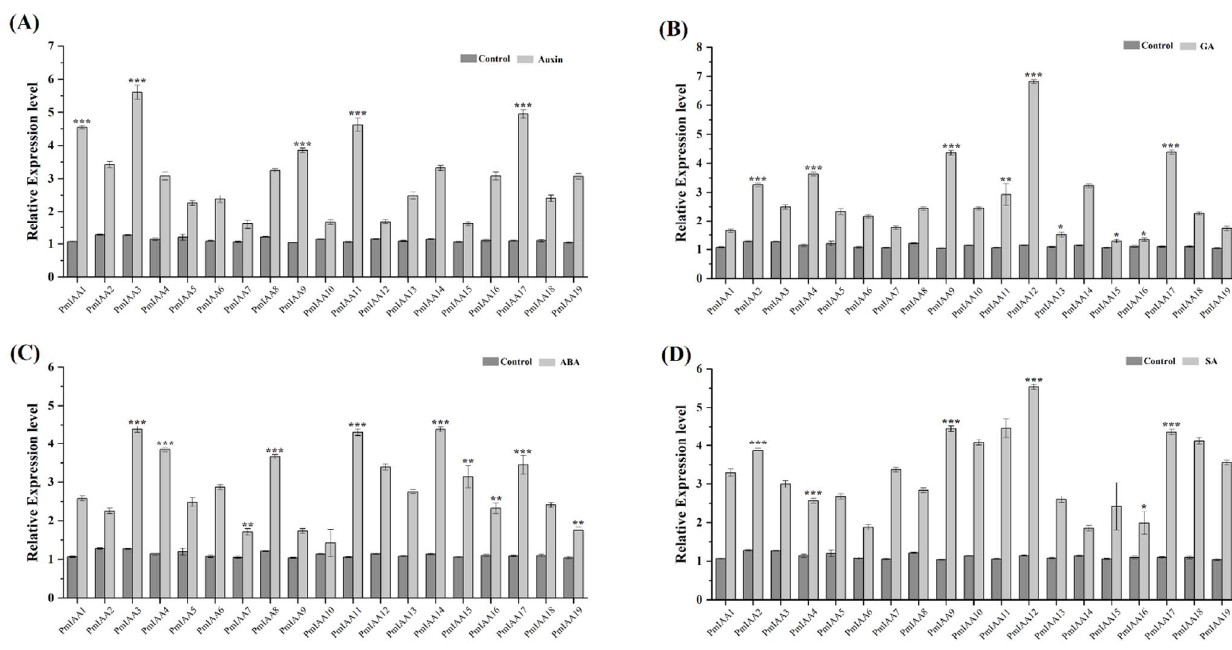
Figure 5. Expression of PmIAA genes in response to ( A ) auxin ( B ) GA ( C ) ABA ( D ) SA treatments was analyzed through qRT-PCR. The expression levels of PmIAA genes in control seedlings were set to a value of 1. The error bar represents the standard error of their biological repeats. Significant differences between control and treated samples are indicated in an asterisk (*). The sign * represents p ≤ 0.05, ** represents p ≤ 0.01 and *** represent p ≤ 0.001.